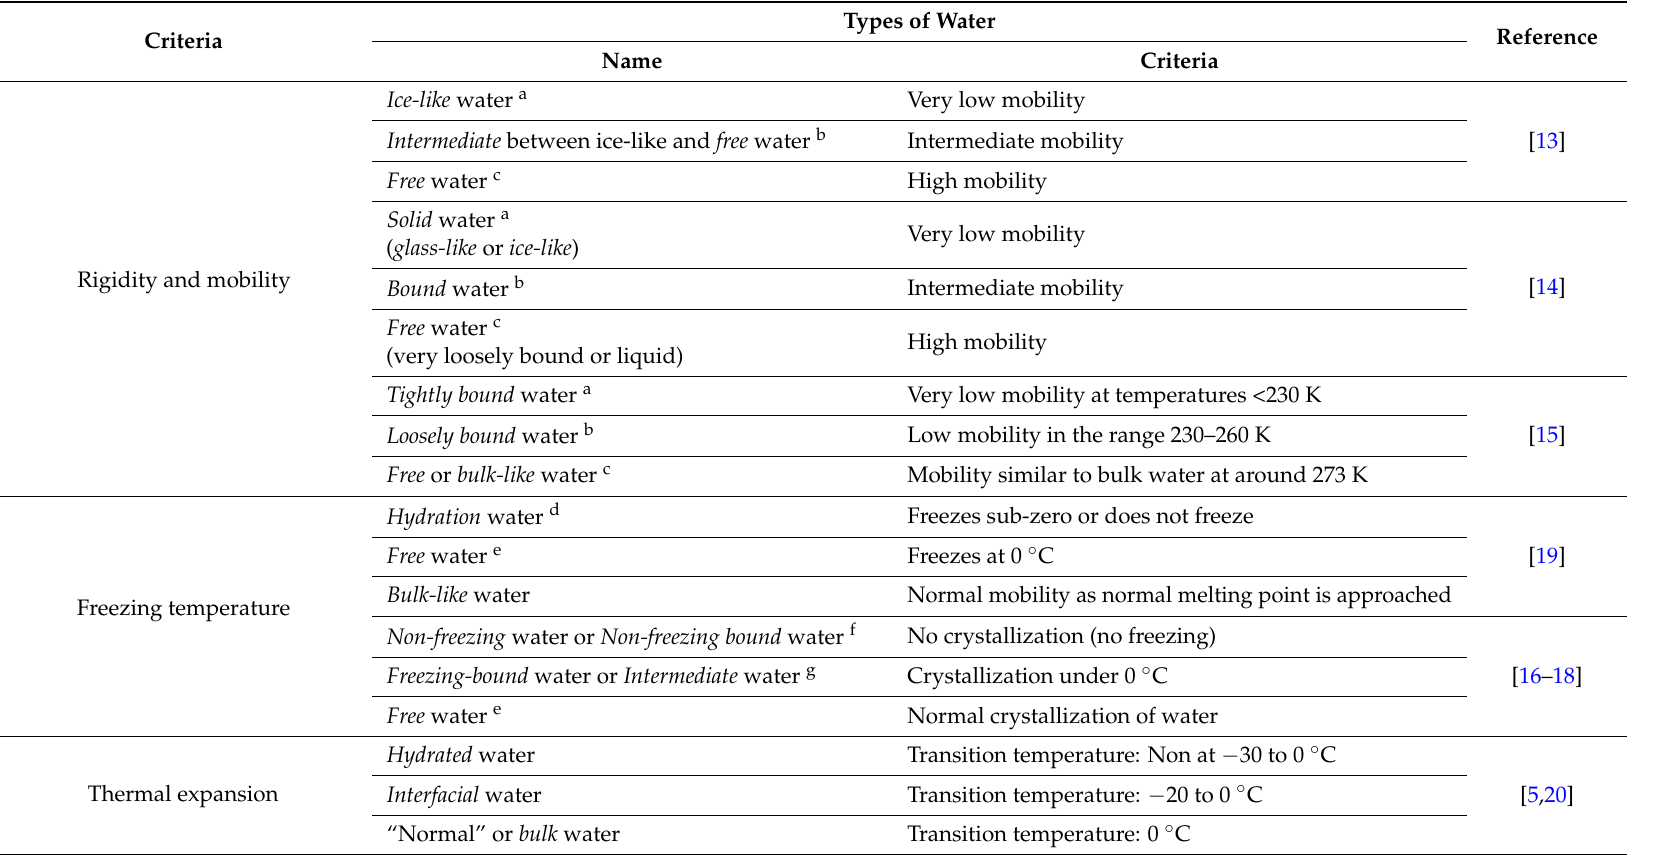
Table 1. Denominations of the types of surface water based on different